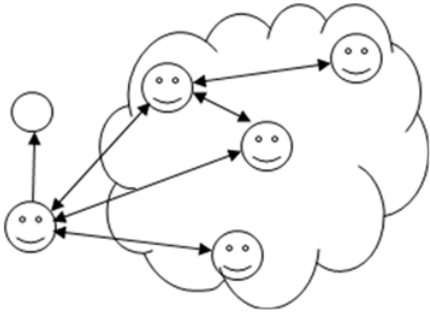
Figure 2. Topology of Opennet. The outside observer can understand the entire network thanks to the existence of a directory